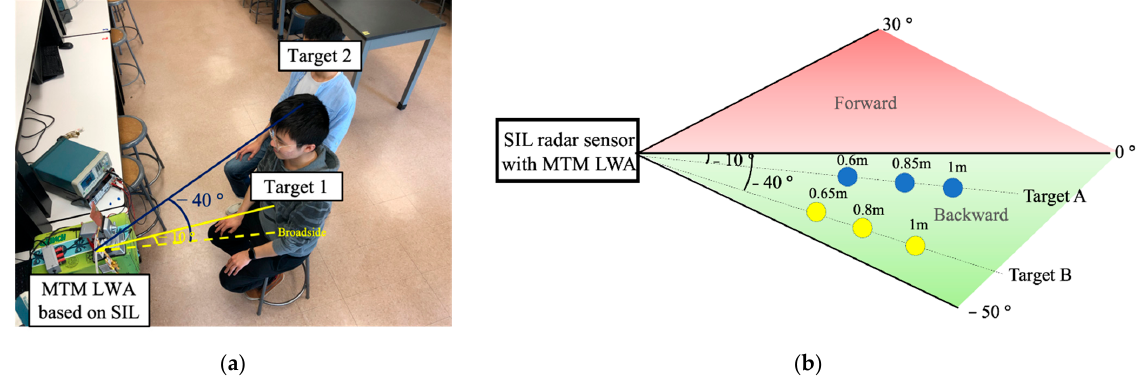
Figure 17. ( a ) Experimental setup for detecting vital sign signals of two targets at different locations using MTM LWA based on SIL radar sensor module; ( b ) its top view sketch [51].